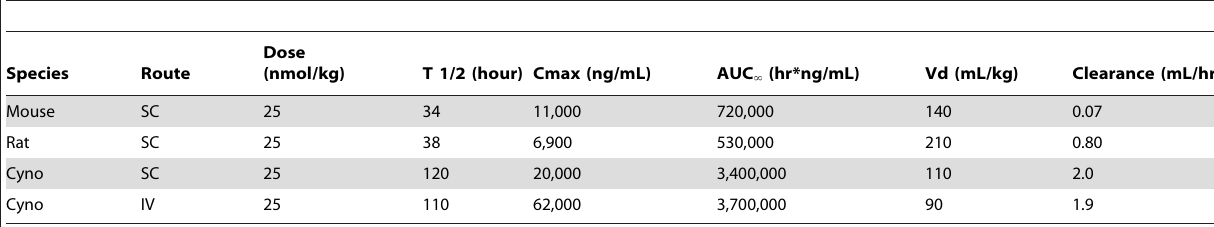
Table 1. Pharmacokinetic data for GLP2-2G-XTEN in mouse, rat and cynomolgus monkey.